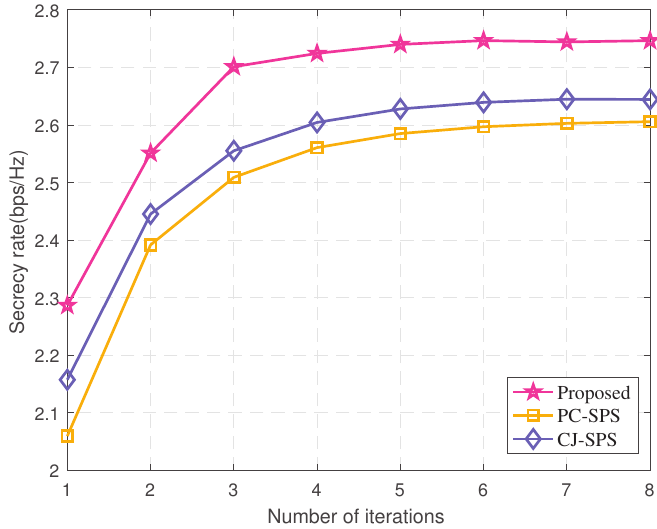
Figure 3. The secrecy rate vs. the number of iterations ( N = 10, K = 5).